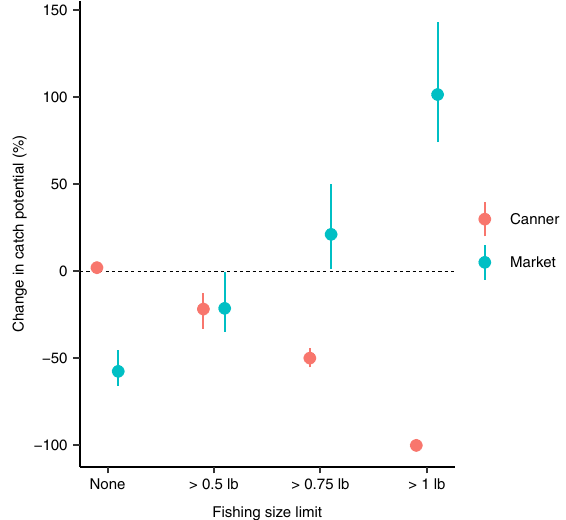
Figure 3. The effect of implementing different fishing size limit on change in maximum catch potential for the two market size categories of H. americanus by end of twenty-first century (2091–2100, relative to 2010) under a high climate change scenario (RCP 8.5), and the effects of implementing fishing size limits. Points represent multi-model means from simulations from three Earth system models and error bars represent the minimum and maximum of the three outputs. Null parameter values were used (Table 2): climate change scenario = RCP 8.5; OA mortality effect size = 15%; OA effects on life stage = all; fishing pressure =